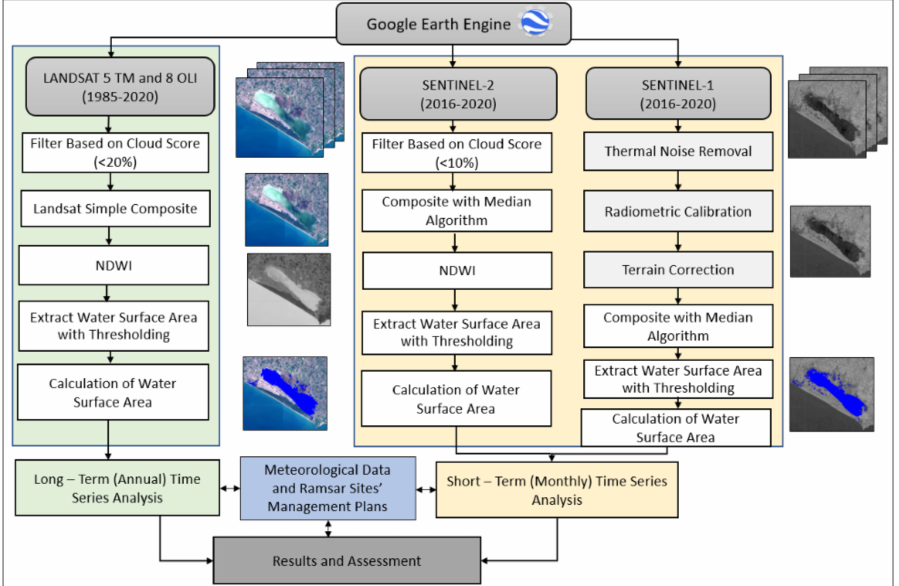
Figure 2. Flowchart of the study of long and short-term water surface changes in coastal Ramsar sites in Turkey with Google Earth